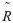
Comparisons on the worst case average percentage of the change in the WSA when disk size R˜ is varied.